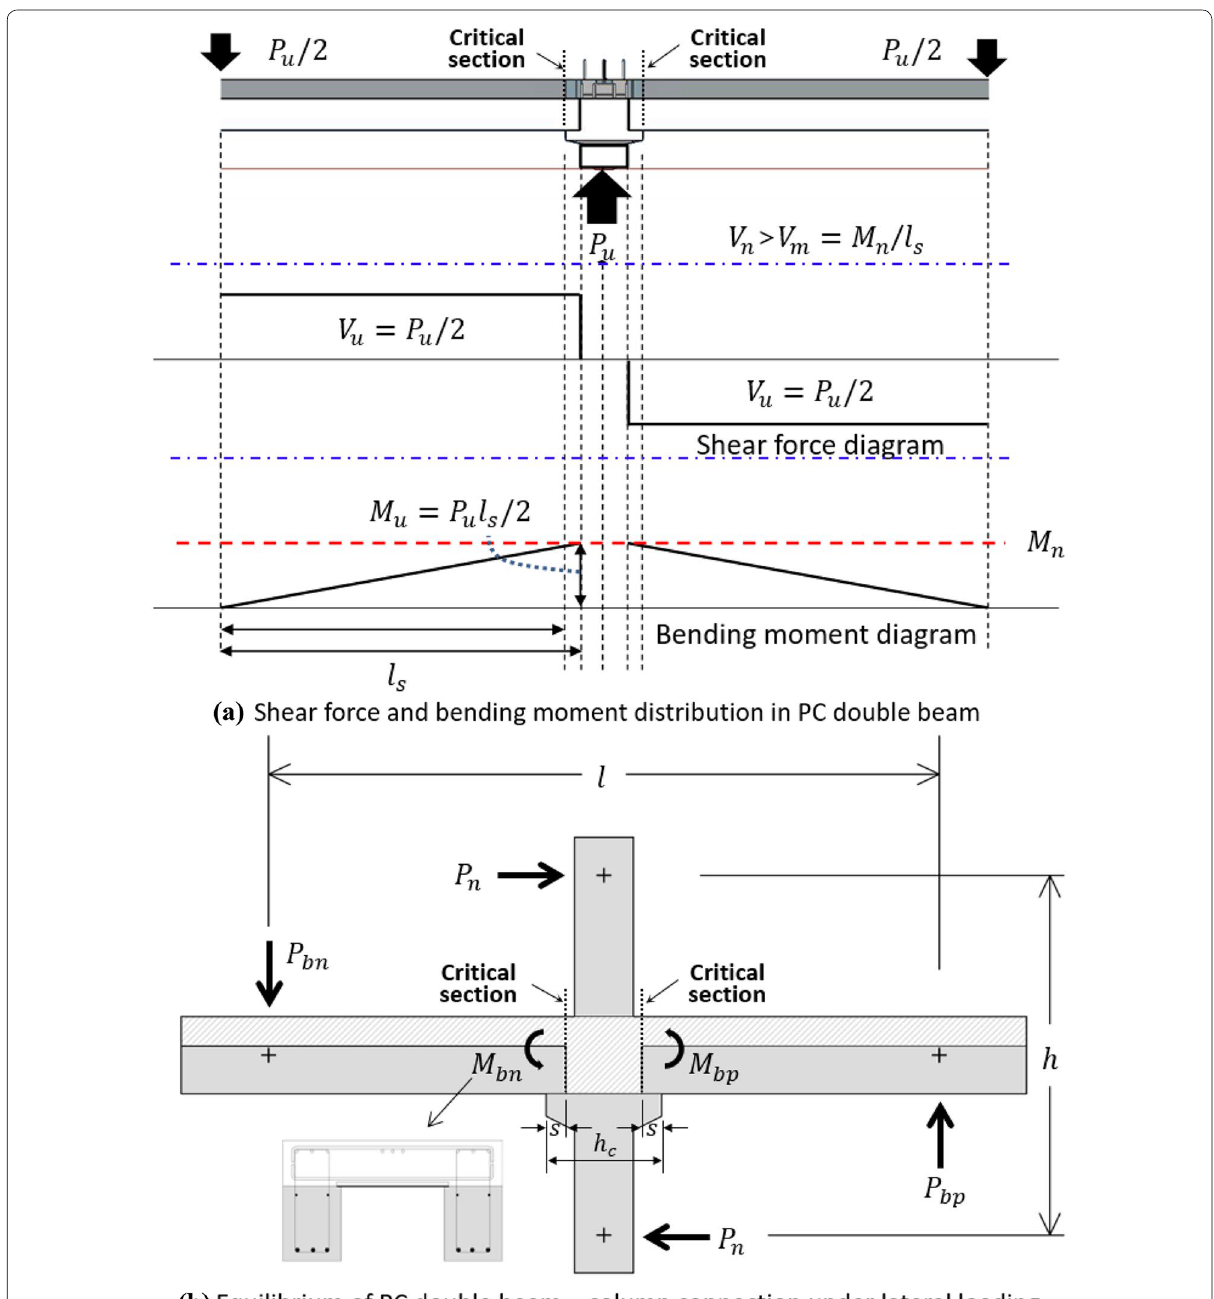
Fig. 4 Design of PC double beam–column